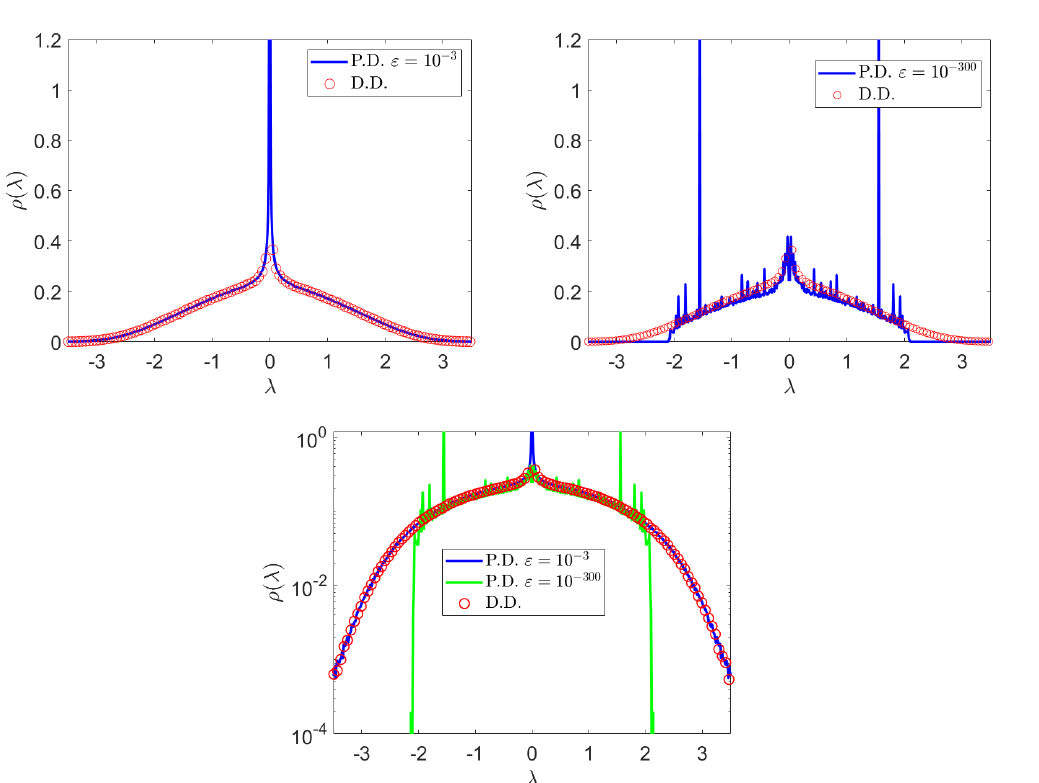
Figure 3: Spectral density of ER matrices with mean degree c = 2 and Gaussian bond weights with zero mean and variance 1 / c . In all panels, direct diagonalisation results (red circles) are obtained from a sample of 10000 matrices of size N = 1000. Top left : population dynamics result obtained with a regulariser (cid:34) = 10 − 3 (solid blue line) vs. the direct diagonalisation results. Top right : population dynamics result obtained with a regulariser (cid:34) = 10 − 300 (solid blue line) vs. the direct diagonalisation results. Bottom : comparison between population dynamics result obtained with a regulariser (cid:34) = 10 − 3 (solid blue line), population dynamics result obtained with a regulariser (cid:34) = 10 − 300 (solid green line) and direct diagonalisation on a logarithmic scale. An extremely small value of (cid:34) is not able to capture the tails of the spectral density related to localised states, where the singular contributions